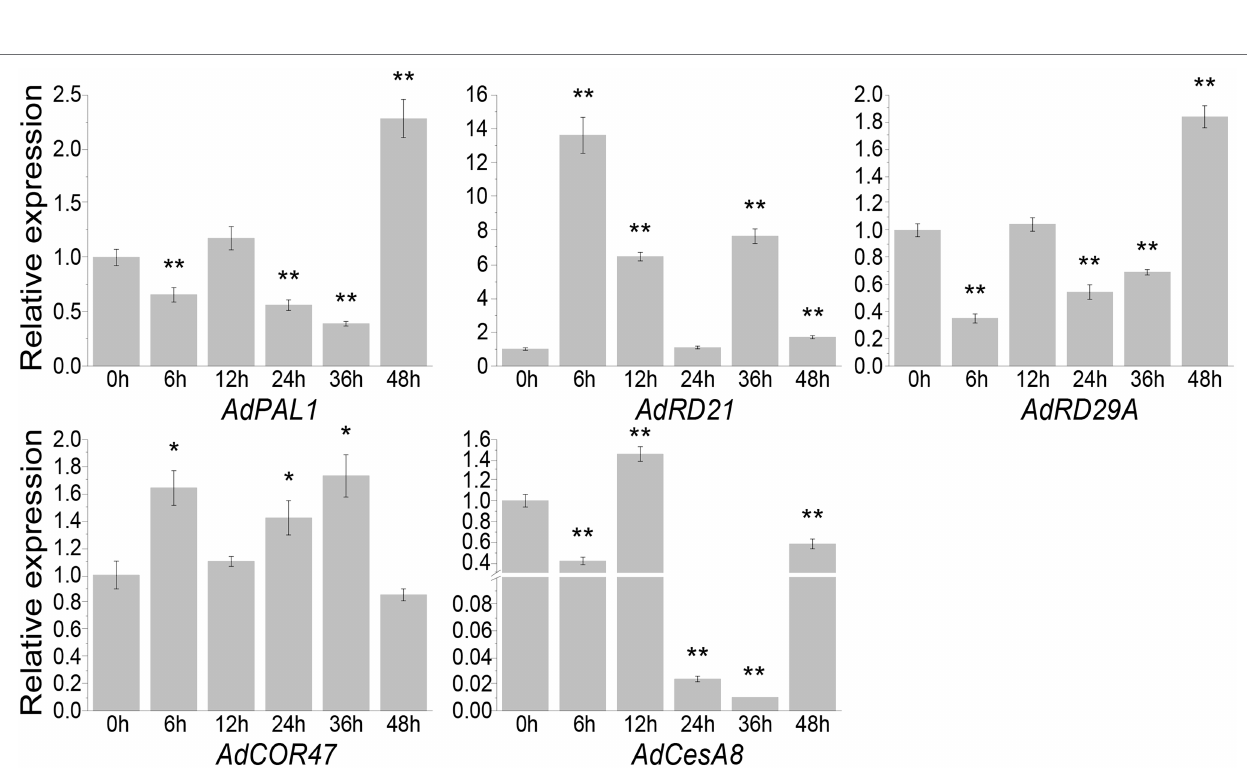
FIGURE 6 | Differential expression levels of AdWRKYs regulating downstream genes under drought stress, assessed using quantitative real-time PCR. Four-leaf plants were treated with 10% (w/v) PEG6000. The leaves were collected after 0, 6, 12, 24, 36, and 48 h of treatments. The control was sampled from 0 h. Three biological replicates were used. Asterisks * and ** indicate significant differences at 0.05 and 0.01 using t tests,